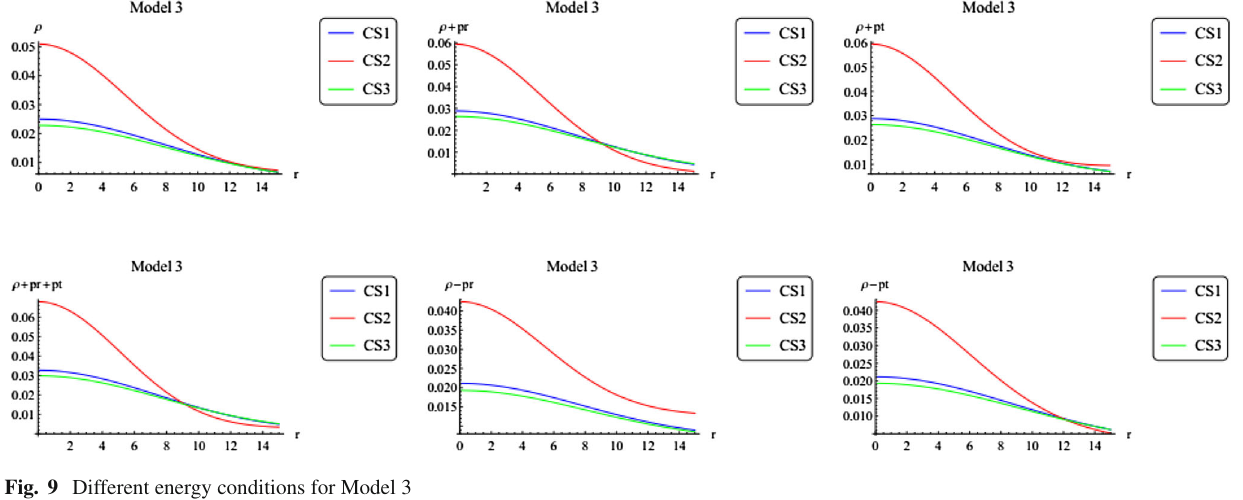
Fig. 9 Different energy conditions for Model 3